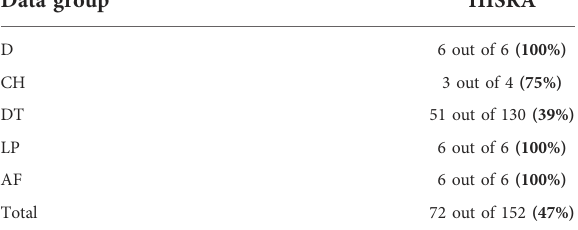
TABLE 3 HISRA of the HIS concerning research and educational data elements. Data group